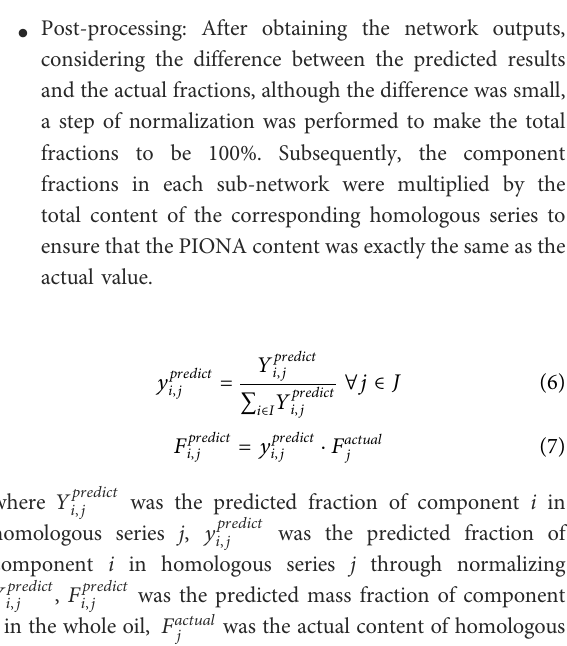
FIGURE 5 The network structure of the reactor